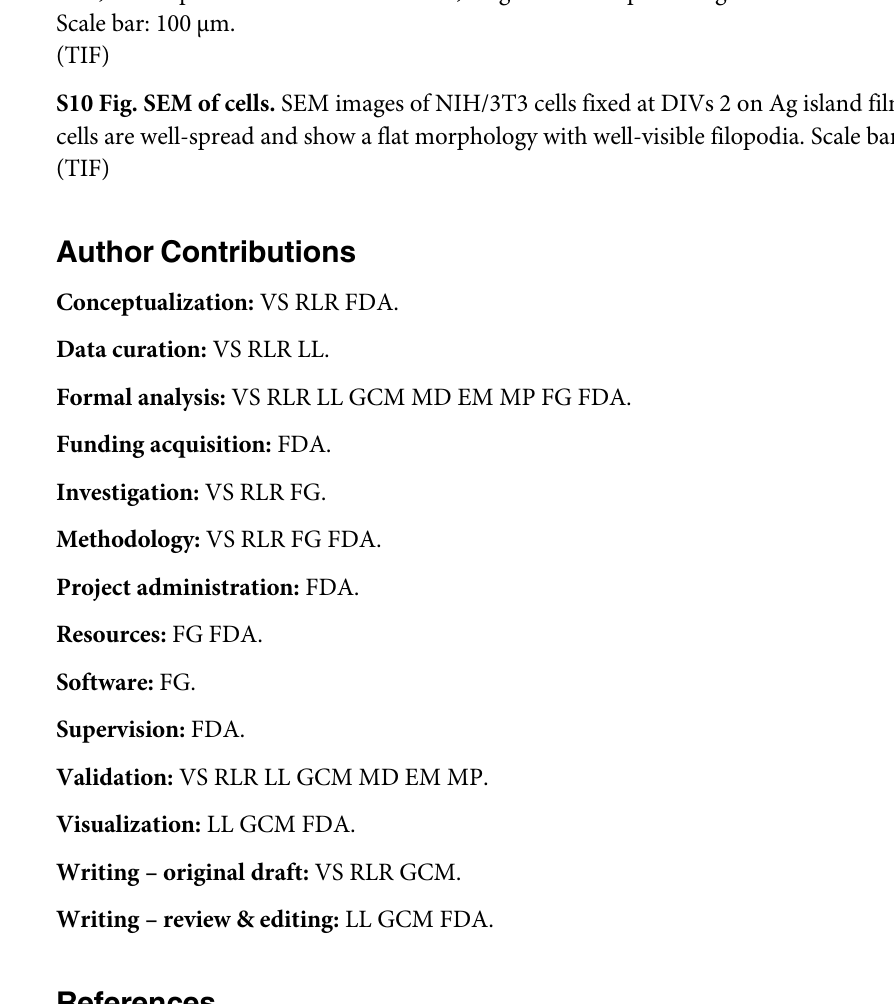
(cid:3)(cid:3)(cid:3) p (cid:20) 0.0002. (b) The viability of NIH/3T3 and Raw 264.7 cells is evidenced by green live cells, in comparison to the red dead cells, on glass coverslips and Ag nanostructured substrates. Scale bar: 100 μm. (TIF) S10 Fig. SEM of cells. SEM images of NIH/3T3 cells fixed at DIVs 2 on Ag island films. The cells are well-spread and show a flat morphology with well-visible filopodia. Scale bar: 20 μm.